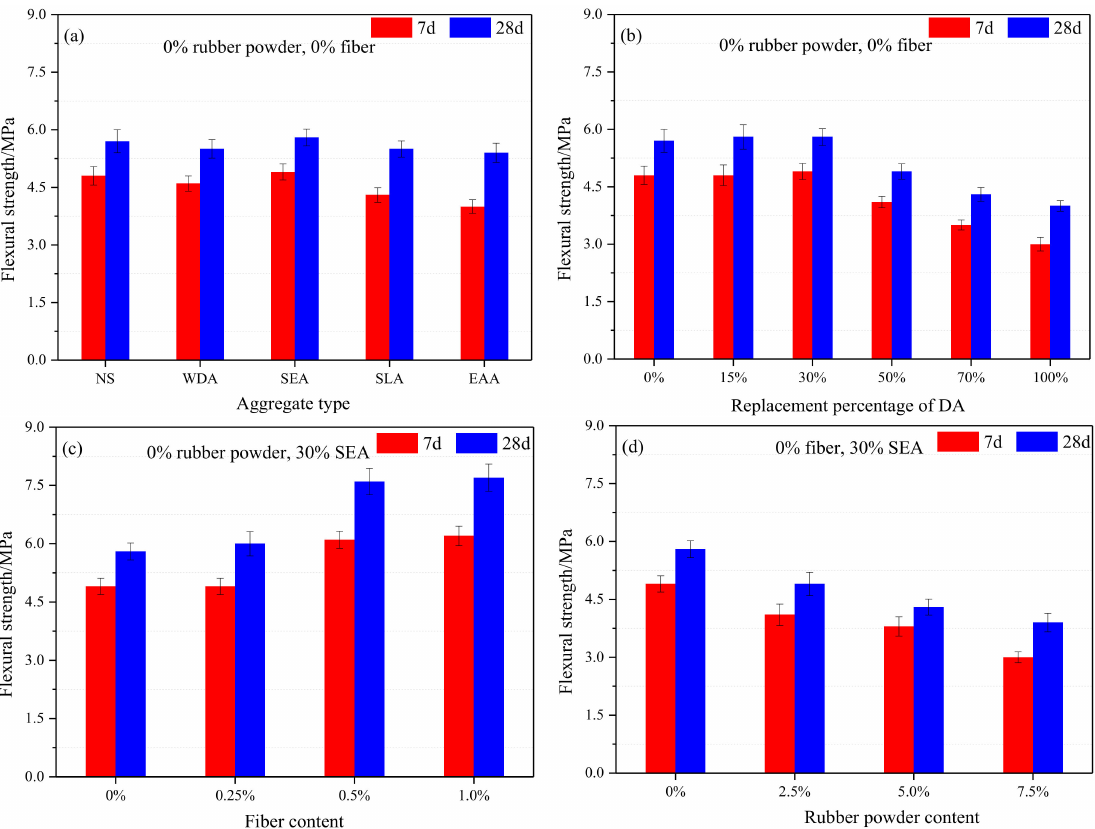
Figure 8. Flexural strength of the cement mortar: ( a ) aggregate type; ( b ) replacement percentage of DA; ( c ) fiber content, and ( d ) rubber powder